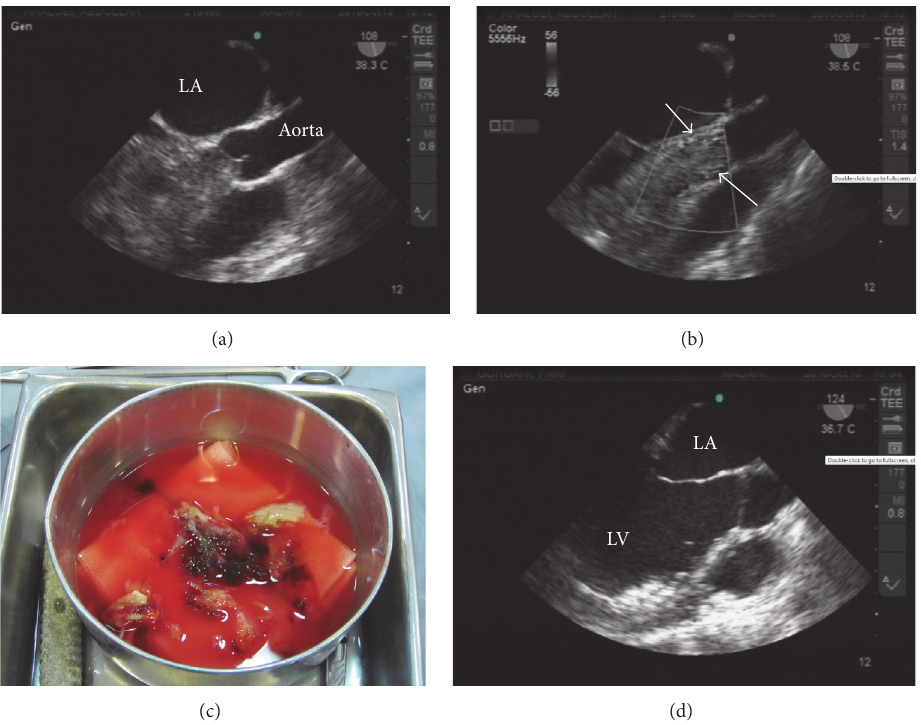
Figure 1: The large left ventricle (LV) mass on intraoperative transesophageal echocardiography (mid esophageal aortic valve, long axis view). Please note its position during diastole (a), systole (b), left ventricular chamber after its removal (d), and limited blood flow around it in color Doppler imaging (b). The mass was classified as a myxoma in histopathologic examination